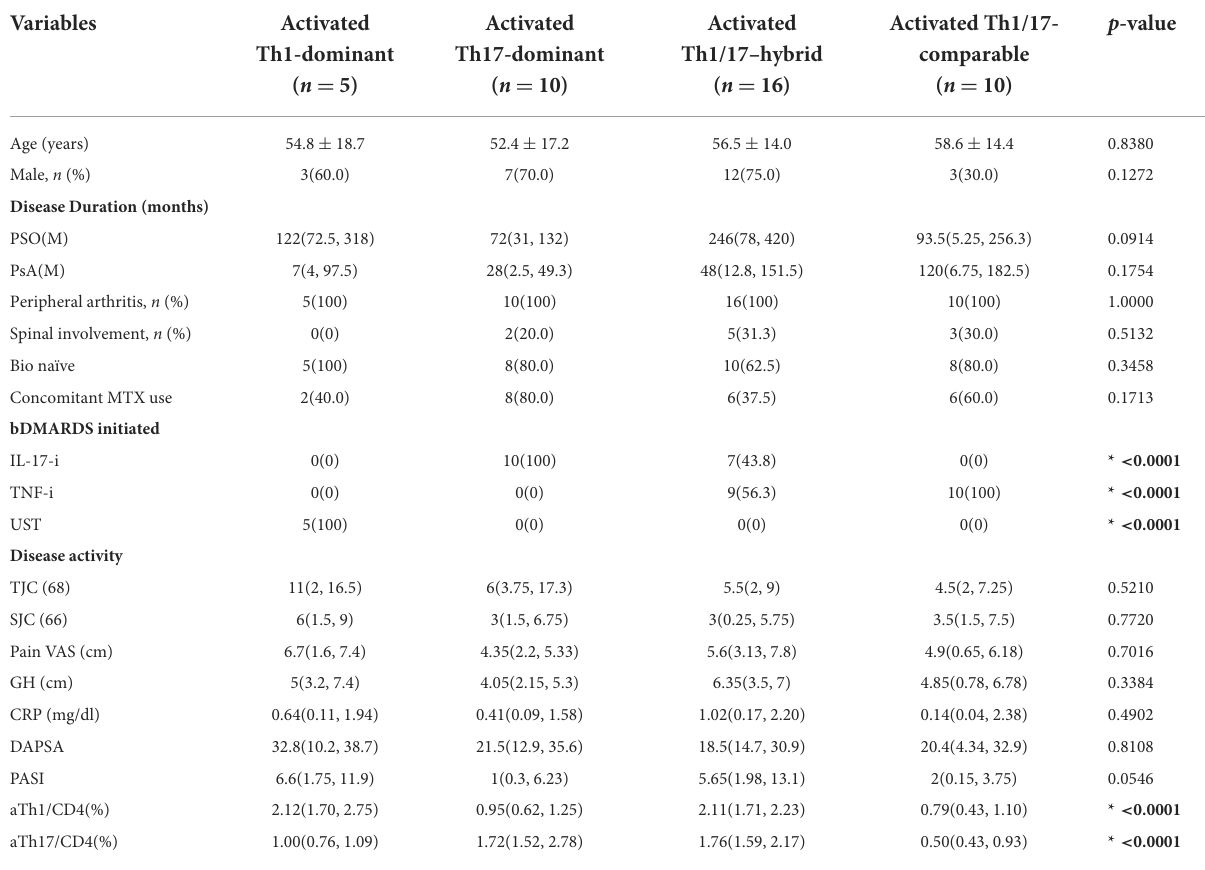
TABLE 4 Comparison of baseline characteristics among 4